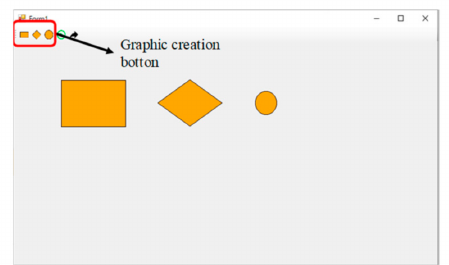
Figure 8. Graphic creation